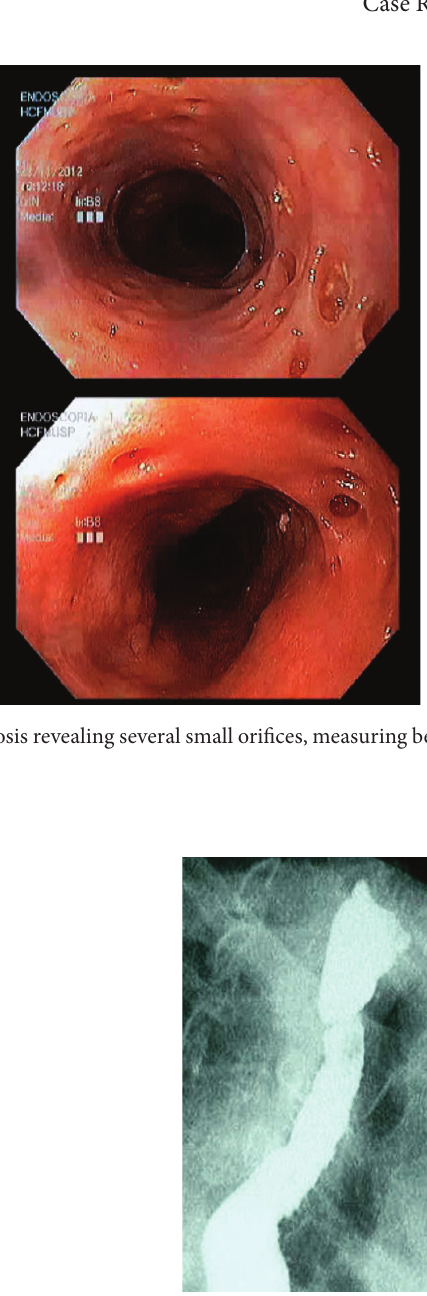
Figure 2: Esophageal barium contrast radiography with a proximal esophageal stricture and small areas of contrast enhancement par- allel to the esophageal wall, compatible with esophageal intramural